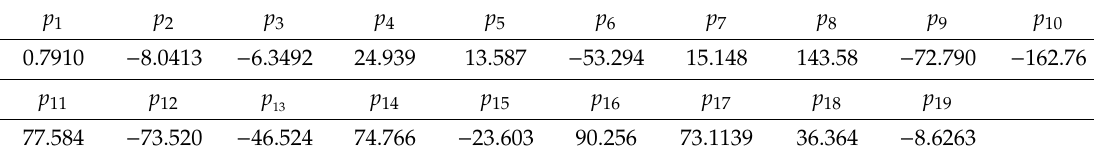
Table 2. The parameters of the reference state of charge (SOC)